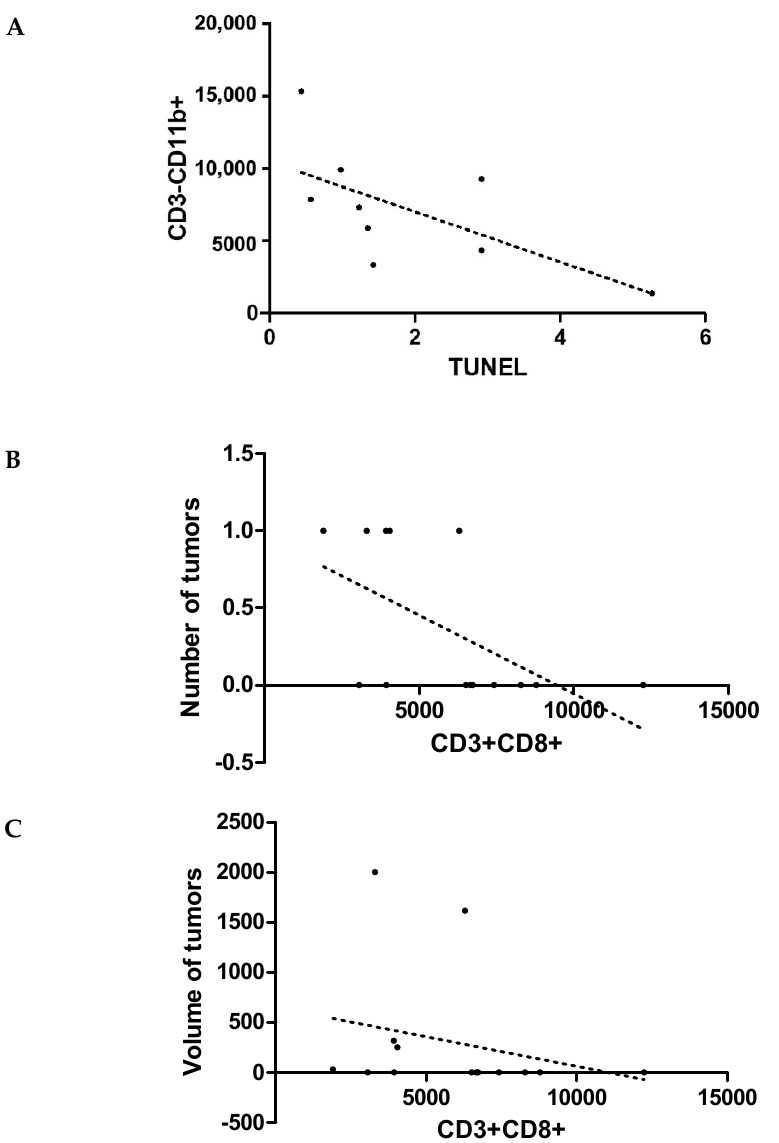
Figure 3. Analysis of Spearman rank correlations in the control group between the number of apoptotic cells and CD3 − /CD11b (r = − 0.76, p = 0.01, ( A )) and in the training group, between the number of induced tumors and CD3+/CD8+ (r = − 0.61, p = 0.02, ( B )), and between their volume and CD3+/CD8+ (r = − 0.56, p = 0.03, ( C